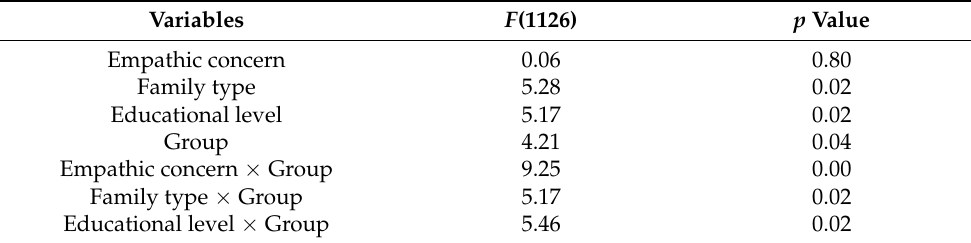
Table 3. Effects of Group, Empathic concern, Family type, Educational level and their interaction with Group on EAA in the final ANCOVA solution a .